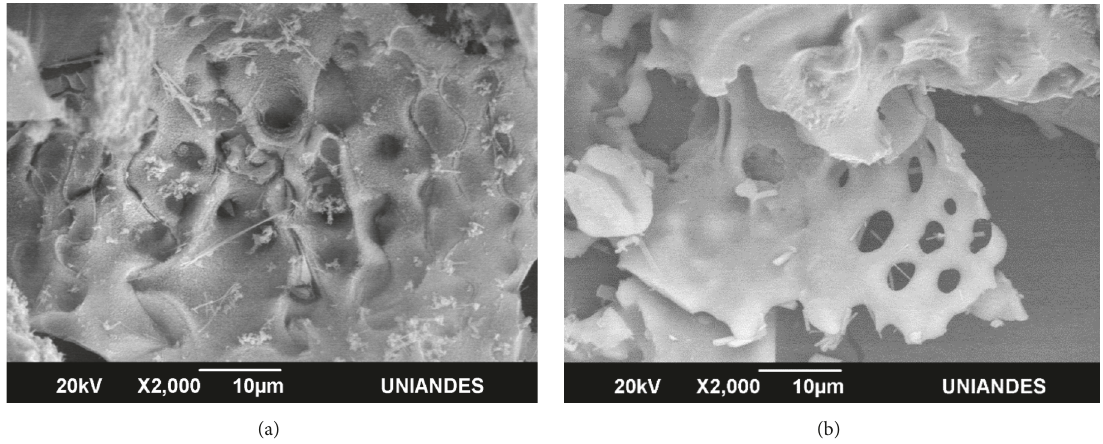
Figure 3: Microphotographs of RHc500 (a) and RHc700 (b) materials.